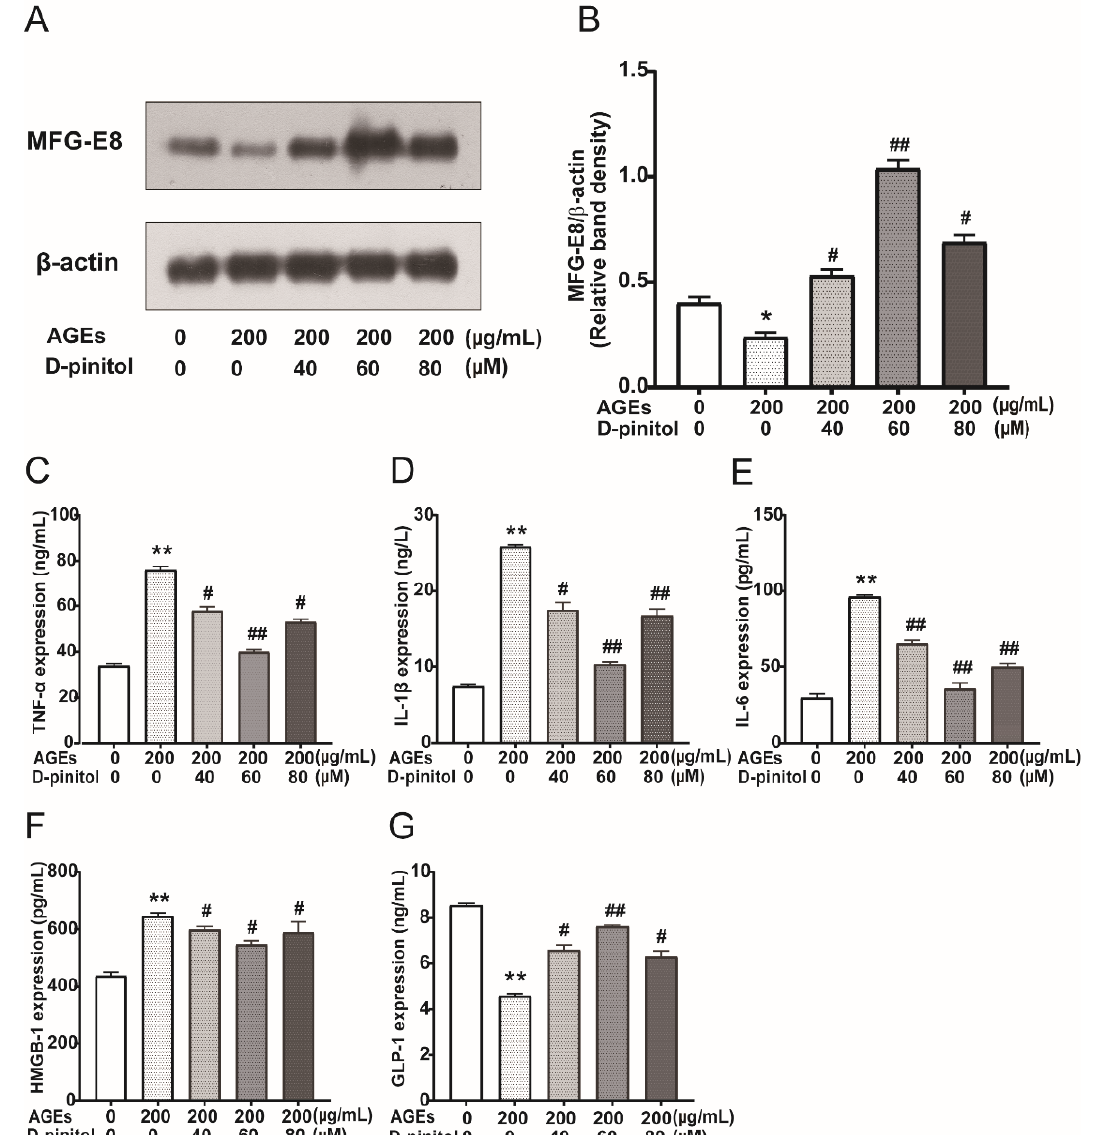
Figure 6. Effects of D-pinitol on MFG-E8 and pro-inflammatory cytokines. ( A ) Western blot showing effects of D-pinitol on the expression of MFG-E8 protein levels in STC-1 exposed to AGEs. ( B ) Data were expressed as the expression ratio of MFG-E8/ β -actin. ( C – G ) ELISA assay revealing HMGB1, TNF- α , IL-1 β , IL-6, and GLP-1 release in presence of AGEs with or without D-pinitol. Results were expressed as the means ± SD from three independent experiments. * p < 0.05, ** p < 0.01 vs. CC group; # p < 0.05, ## p < 0.01 vs. CC + AGEs group. AGEs: advanced glycation end products.